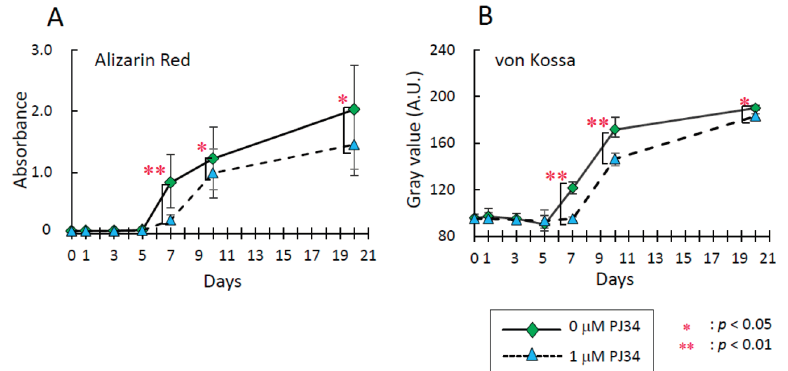
Figure 4. Effects of PJ34 on osteogenic differentiation of BMMSCs were analyzed by visualizing calcium deposition with Alizarin Red S staining ( A ) and deposition of calcium phosphate and calcium carbonate with von Kossa staining ( B ); ( C ) Representative photos of Alizarin Red S staining and von Kossa staining of BMMSCs during osteogenic differentiation. Values are expressed as mean ± SEM. A.U. = Arbitrary Unit. * p < 0.05, ** p <